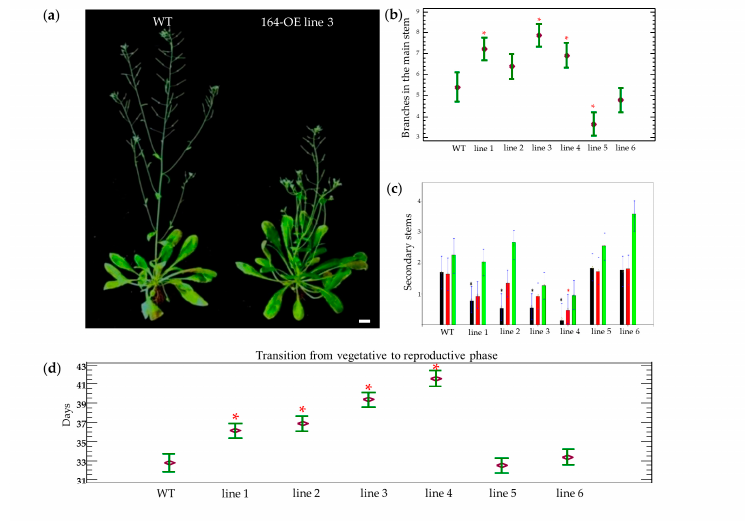
Figure 2. Phenotypic effects observed in the 164-OE Arabidopsis lines. ( a ) Plants with more severe phenotypes of 164-OE lines. Scale bar = 1 cm; ( b ) Quantification of branches in the main stem (WT n = 15, line 1 n = 26, line 2 n = 21, line 3 n = 26, line 4 n = 21, line 5 n = 25, line 6 n = 22); ( c ) Quantification of secondary stems at 7 (black bars), 9 (red bars), and 11 (green bars) weeks post-germination (WT n = 17, line 1 n = 26, line 2 n = 26, line 3 n = 27, line 4 n = 21, line 5 n = 25, line 6 n = 22); ( d ) Days required for the transition from the vegetative to the reproductive phase (WT n = 17, line 1 n = 26, line 2 n = 26, line 3 n = 27, line 4 n = 21, line 5 n = 25, line 6 n = 22). n , indicates the number of plants analyzed. For all cases, the means and Least Significant Difference (LSD) intervals at a confidence level of 95% were plotted. * indicates that there is a statistically significant difference.